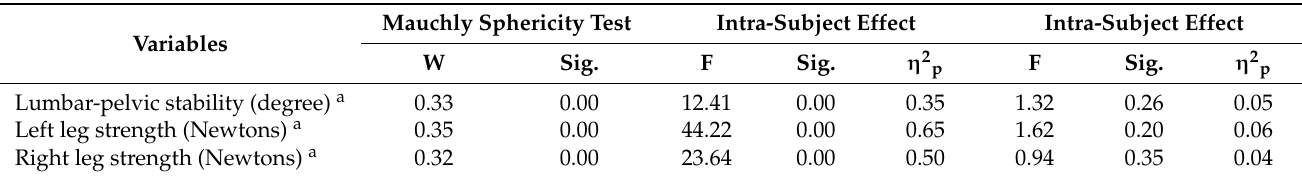
Table 4. Statistical analysis of repeated measures of the dependent variables in the baseline, posttreatment and follow-up assessments.